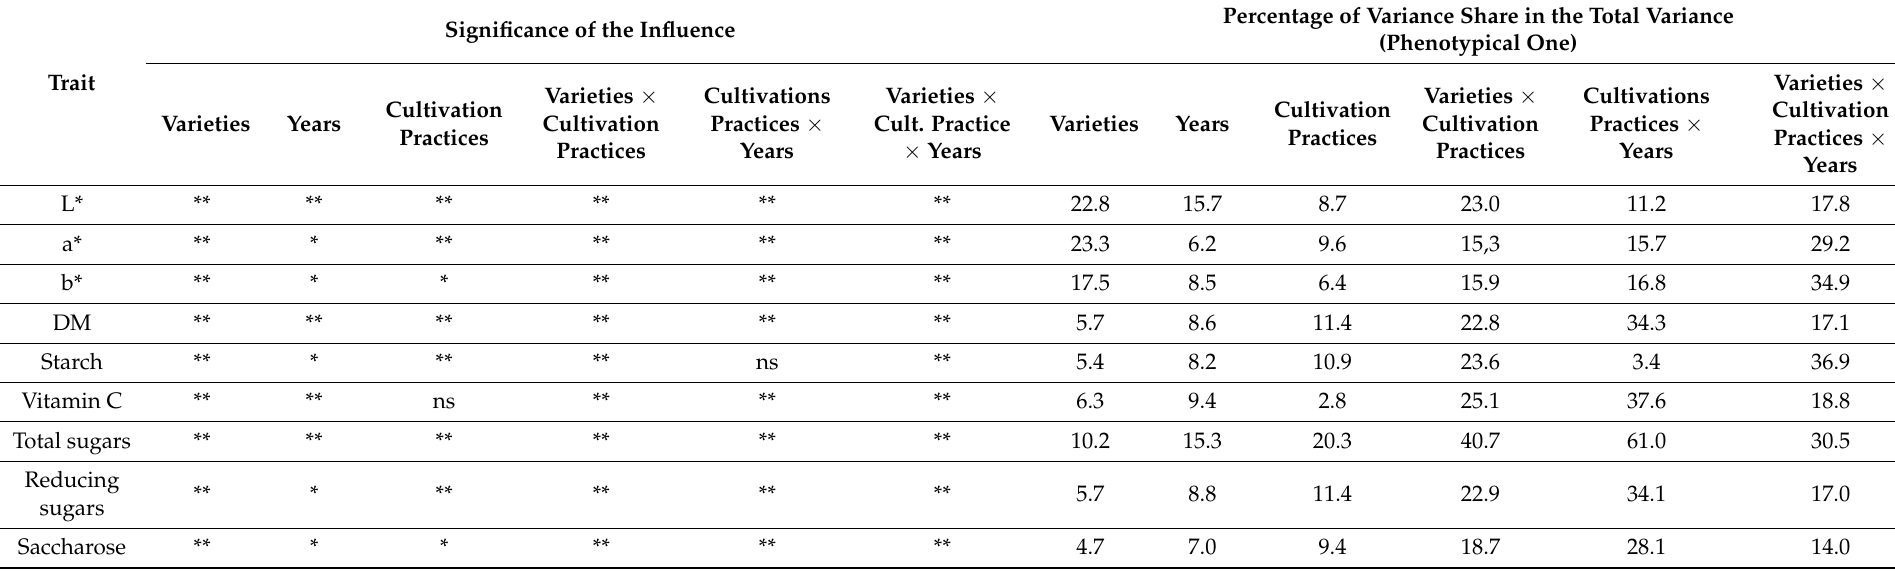
Table 12. Influence of varieties, cultivation practices, years, and their interactions on the color parameters of raw potato flesh, DM, starch, total sugars, reducing sugars, saccharose and their percentage share of total